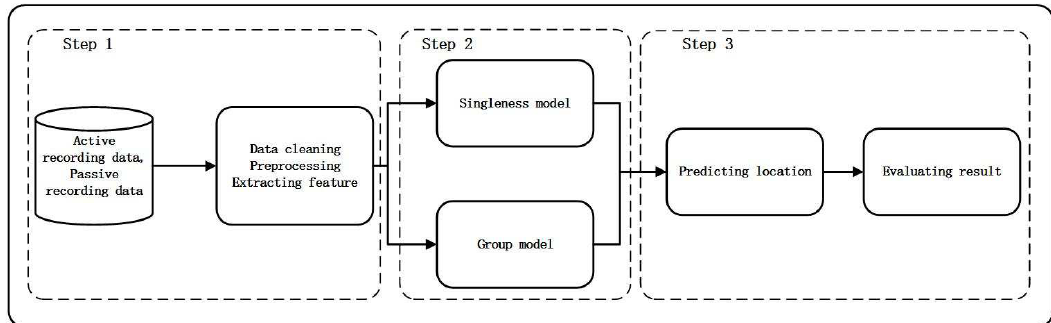
Fig. 2 Popular general framework of location prediction in which the integration of single object and group models is an emerging